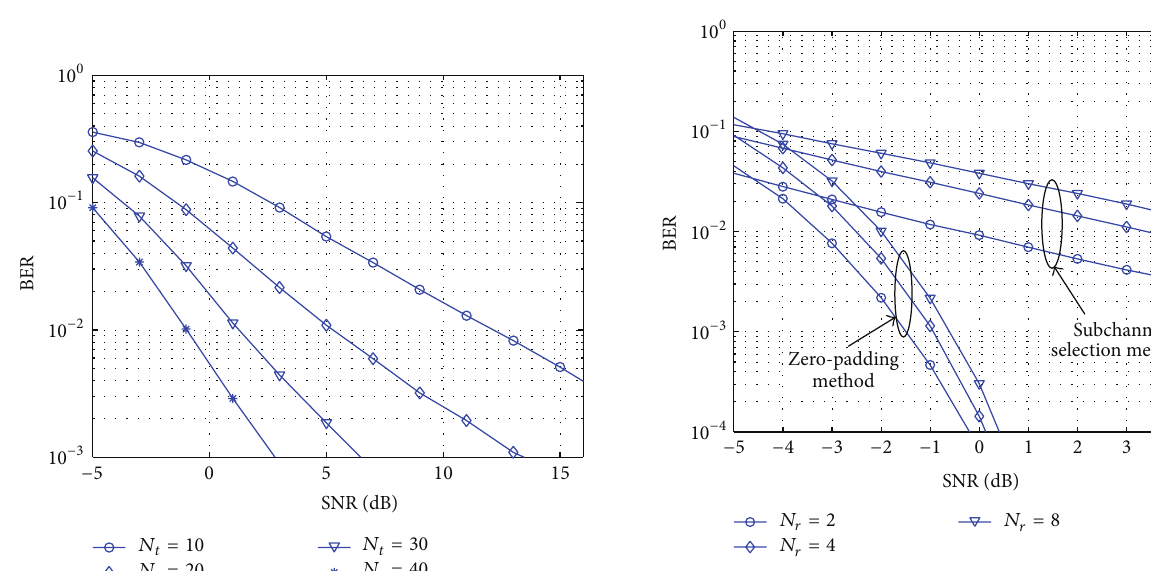
Figure 4: BER Performance of subchannel selection method with different number of transmit antennas for 𝐾 = 5 and 𝑁 𝑟 = 2 for QPSK modulation.